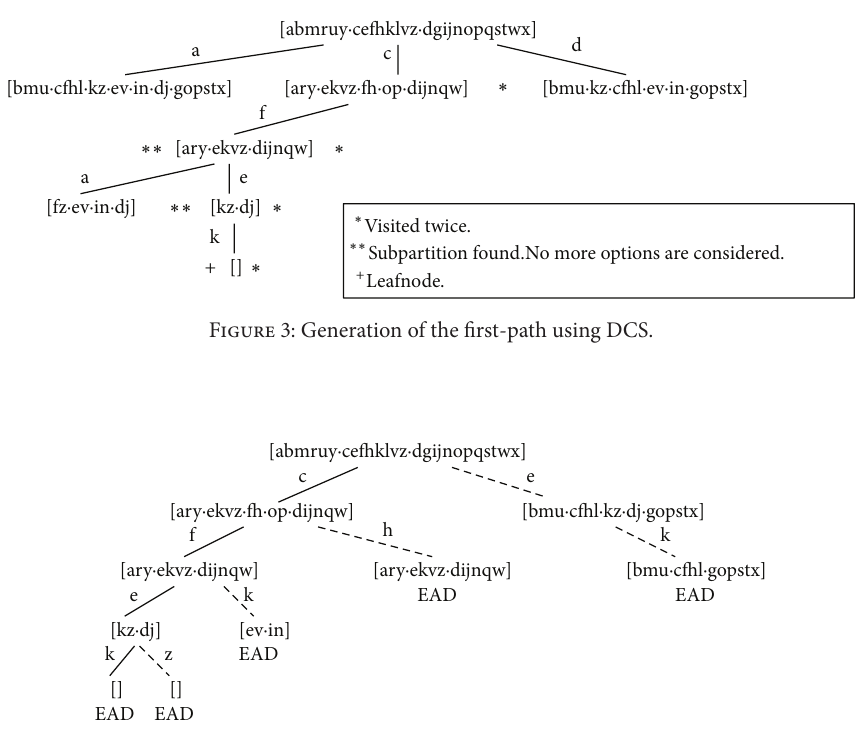
Figure 4: Search tree using DCS and EAD (other techniques do not apply